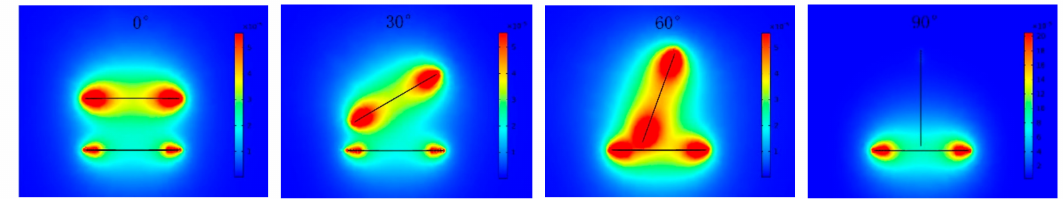
Figure 8. Magnetic flux density with di ff erent angular deviations in symmetrical